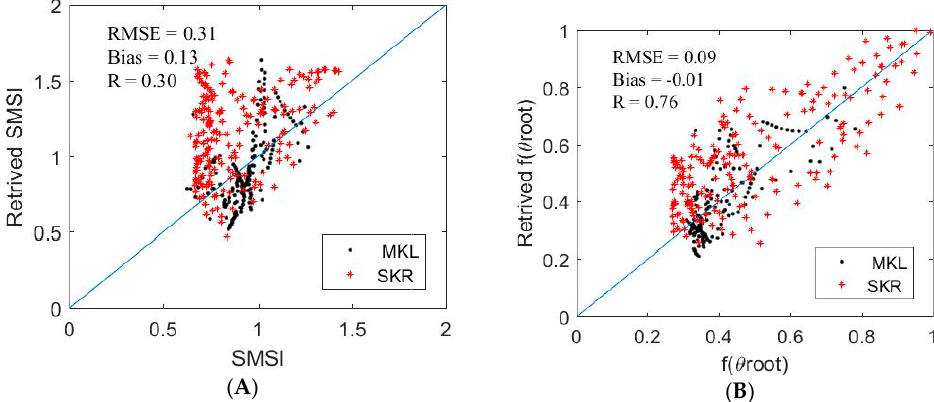
Figure 3. The relationship between soil moisture at 10 cm ( θ 10cm ) and f ( θ 50cm ) at ( A ) MKL site and ( B ) SKR site at a wet-dry episode. Linear equations are used for fitting(y = 3.42 x − 0.28 with R 2 = 0.99 from 27 October 2003 to 5 February 2004 and y = 0.12 x − 0.31 with R 2 = 0.20 from 7 February 2004 to 14 March 2004 in MKL, y = 17.87 x − 1.87 with R 2 = 0.96 from 3 November 2002 to 8 December 2002 and y = 4.80 x − 0.15 with R 2 = 0.97 from 24 December 2002 to 24 February 2003 in SKR).